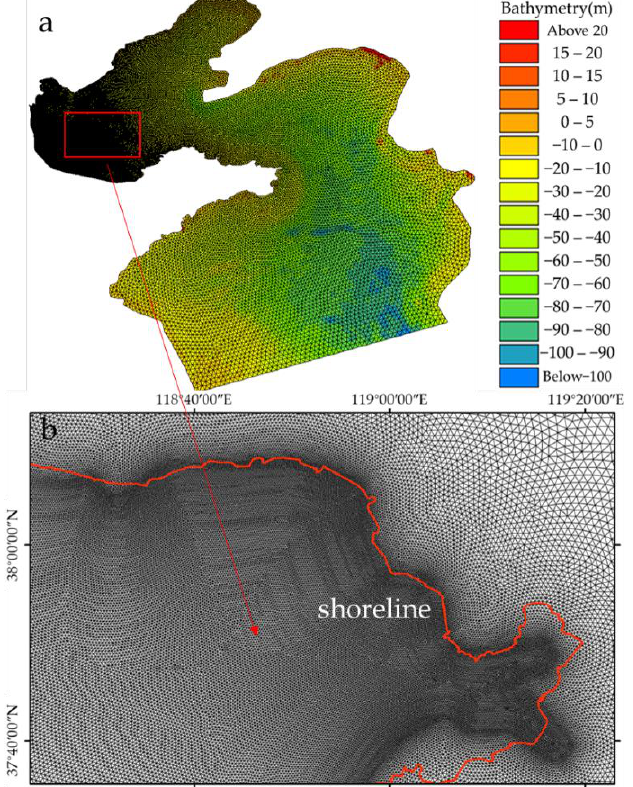
Figure 4. Mesh of computing domain (( a ): model computing mesh; ( b ): delta position refinement grid).